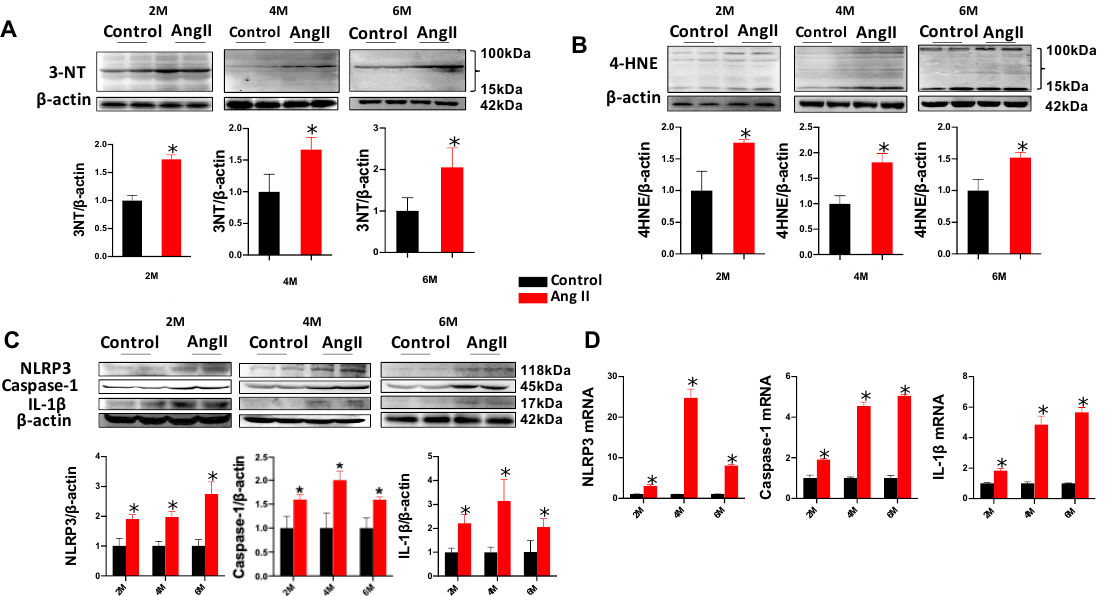
Figure 2. Ang II treatment induces cardiac oxidative damage and activation of NLRP3 inflammasome. Mice were treated as described in Figure 1. Western blot analysis was applied to detect the expression of 3-NT ( A ) and 4-HNE ( B ). The expression of NLRP3 and its downstream genes of caspase-1 and IL- 1β was examined by western blot ( C ), and the transcription of NLRP3, caspase-1 and IL- 1β was quantified by qPCR ( D ), along with quantitative analysis. Data are presented as the mean ± SD ( n = 7 – 9). * p < 0.05 vs. Control.